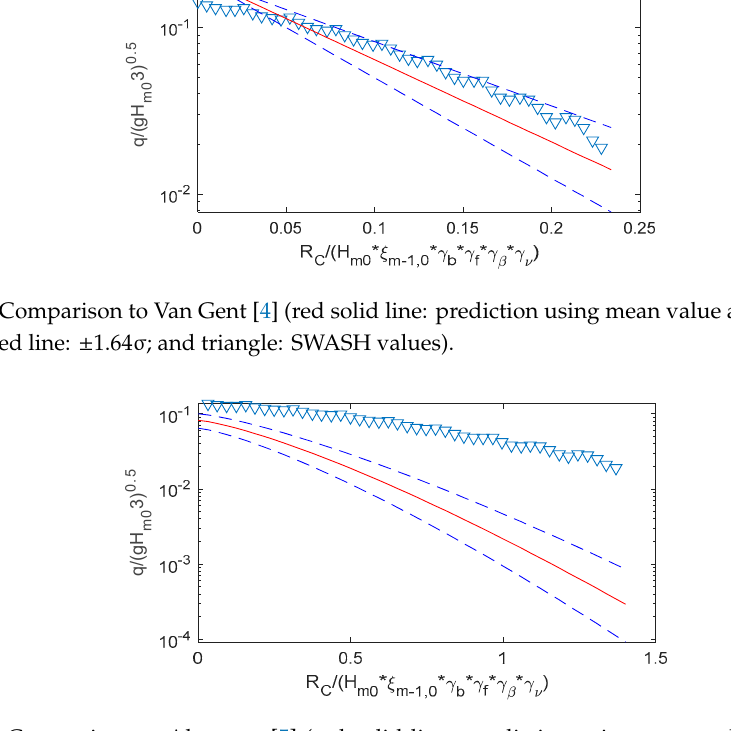
Figure 12. Comparison to Altomare [5] (red solid line: prediction using mean value approach of Altomare; dashed line: ± 1.64 σ ; and triangle: SWASH values).